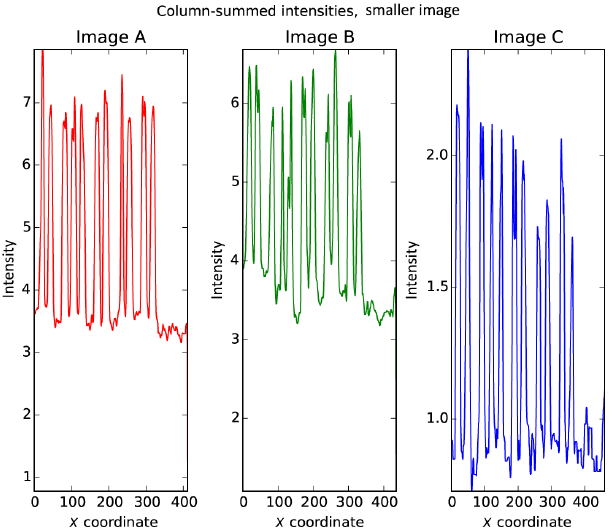
Figure 11. Average filtered column-summed intensities of the pre- vious